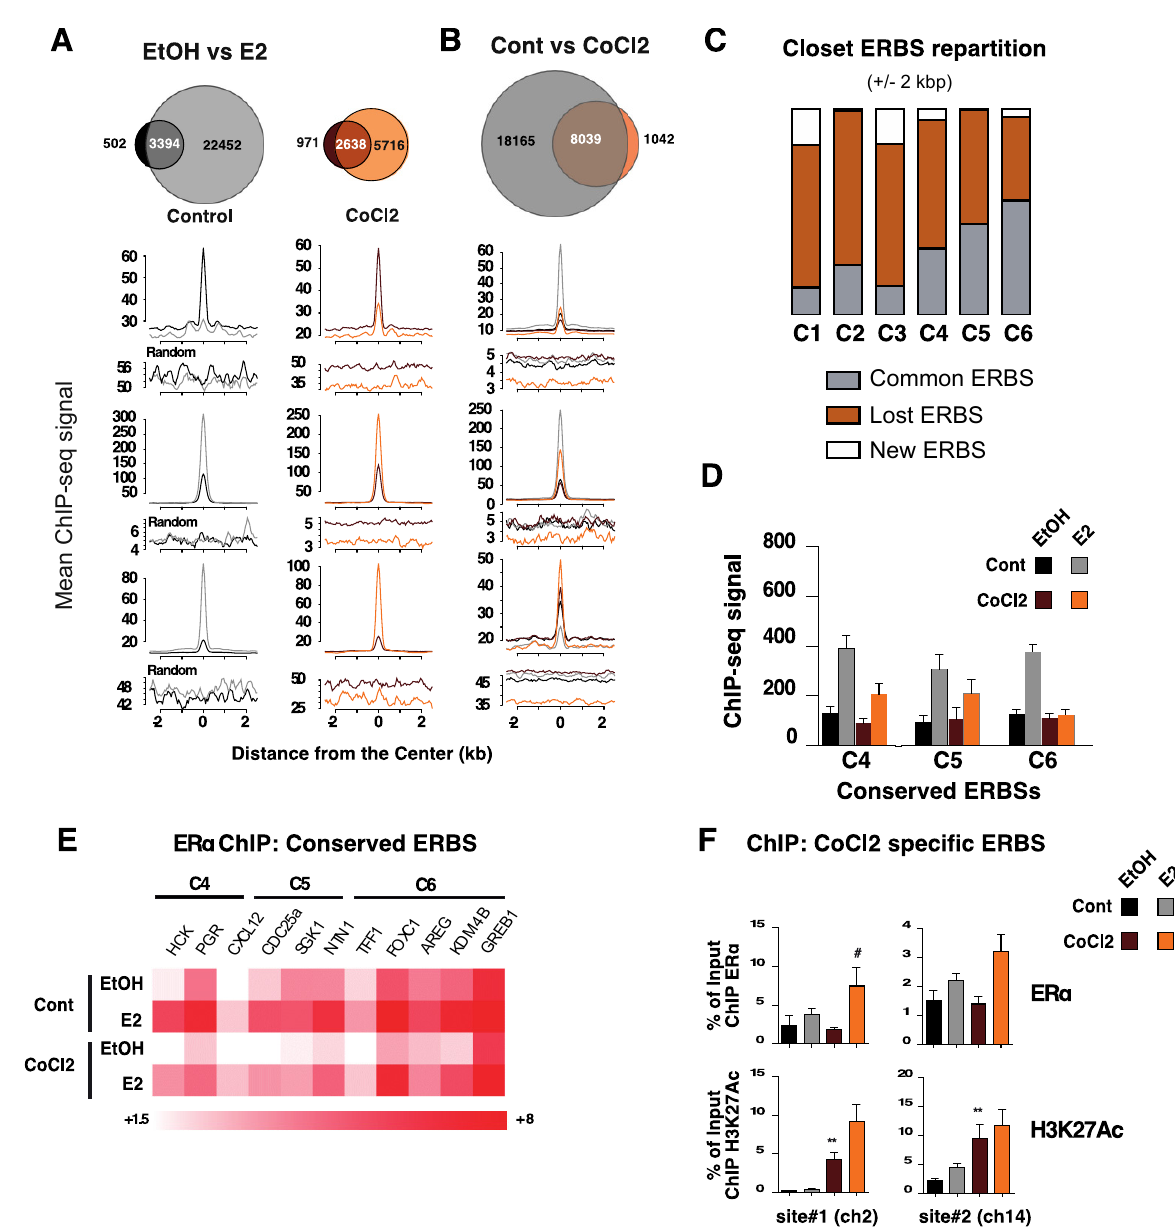
Figure 3. Genome-wide reprogramming of ER α cistrome under hypoxic stress. ( A , B ) Venn diagrams showing the overlaps of genomic regions bound by Er α detected by ChIP-seq, both in control or CoCl2-treated MCF7 cells, following a 50 min treatment with E2 or EtOH. The Er α ChIP-seq signal was aligned and averaged within a − 2/+2 kbp window centered on ERBS belonging to the 3 categories in the upper Venn diagrams. ( C ) The stacked histogram illustrates the percentage of conserved, lost and gained ERBSs according to each cluster. ( D ) Graphs representing the mean of ER α ChIP-seq signal obtained at the center of the conserved ERBSs located at the vicinity of the TSSs of the genes clustered in C4, C5 and C6 obtained from transcriptomic analysis. ( E ) Heatmap of ER α targeted CHIP-qPCR experiments on conserved ERBSs at the vicinity of genes belonging to the clusters C4, C5 and C6. Data shown are the mean of relative enrichment of five independent experiments normalized to an internal control. ( F ) ER α and H3K27Ac CHIP experiments on CoCl2-specific ERBSs. Data shown are the mean of relative enrichment of five independent experiments normalized to an internal